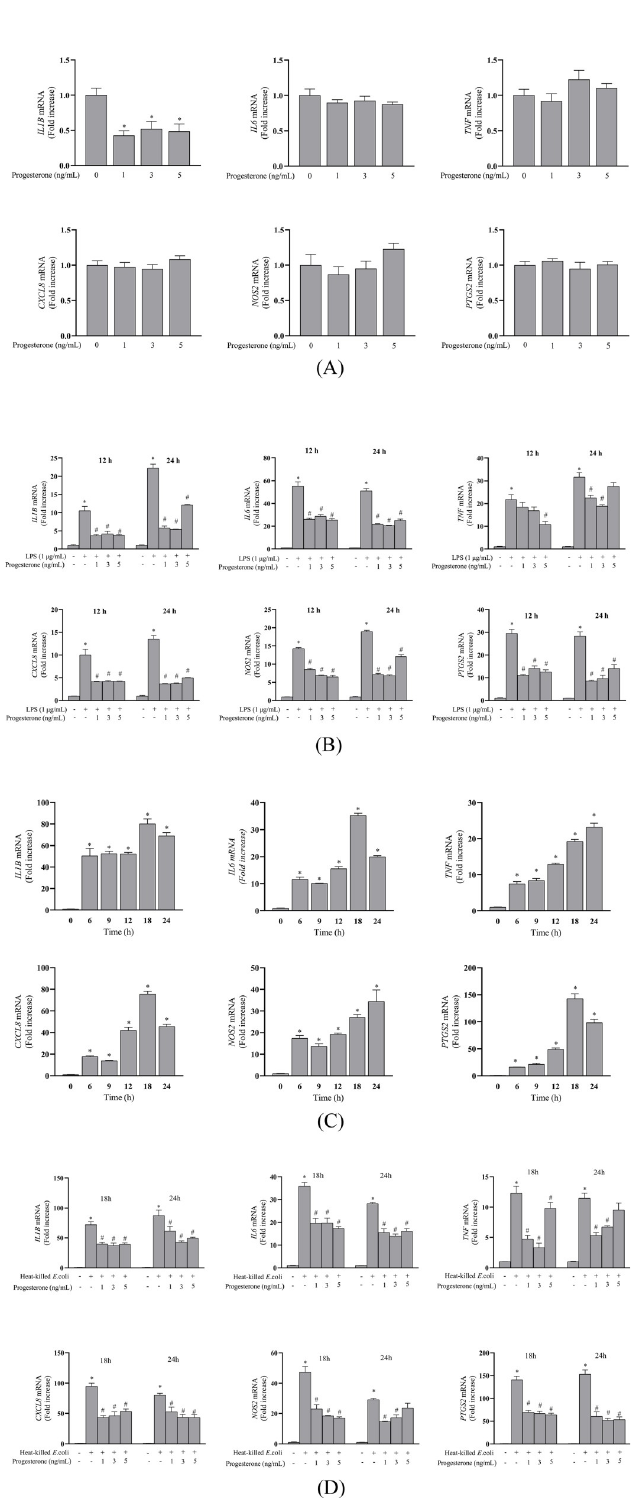
Fig 2. Progesterone treatment attenuated gene expression of inflammatory mediators in primary bovine endometrial stromal cells stimulated with lipopolysaccharide or heat-killed E . coli . The mRNA expressions of IL1B , IL6 , CXCL8 , TNF , NOS2 , and PTGS2 were assessed by qPCR (normalized to ACTB ). A. Unstimulated cells were treated with 1, 3, and 5 ng/mL progesterone for 12 h. B. Cells were cotreated with 1 μ g/mL lipopolysaccharide and progesterone (1, 3, and 5 ng/mL) for 12 and 24 h. C. Time-course changes in inflammatory gene expressions in